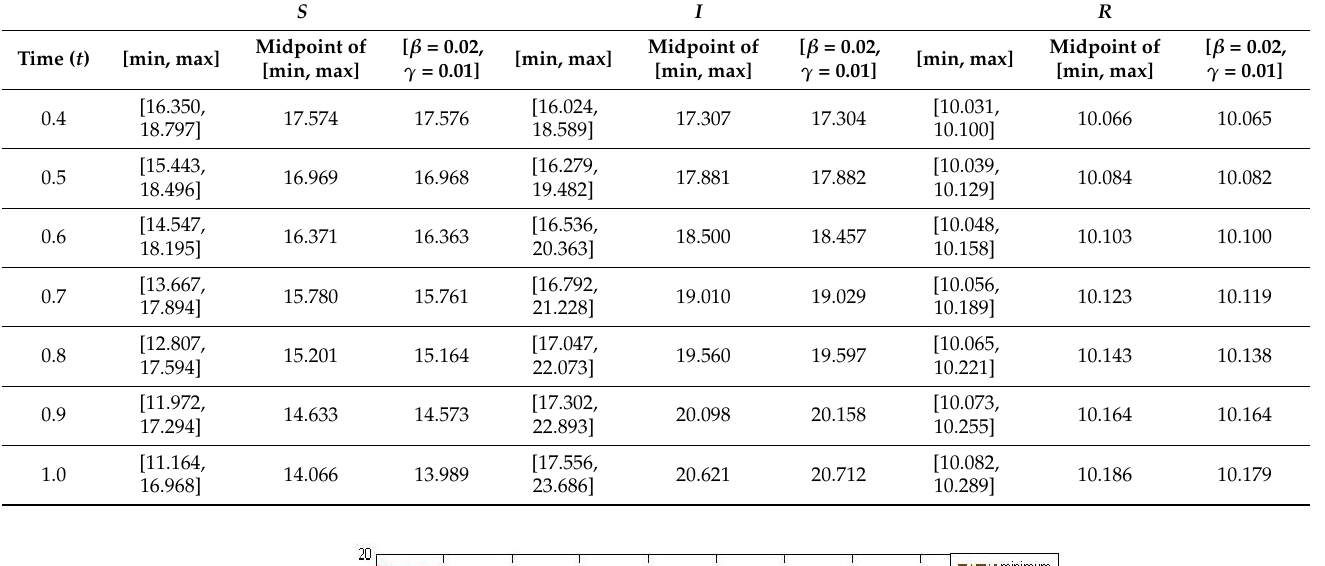
Table A4. The solutions obtained by the homotopy analysis method with intervals (cid:2010)(cid:3560) = [0.01,0.03] and (cid:2011)(cid:3556) = [0.01,0.015] .